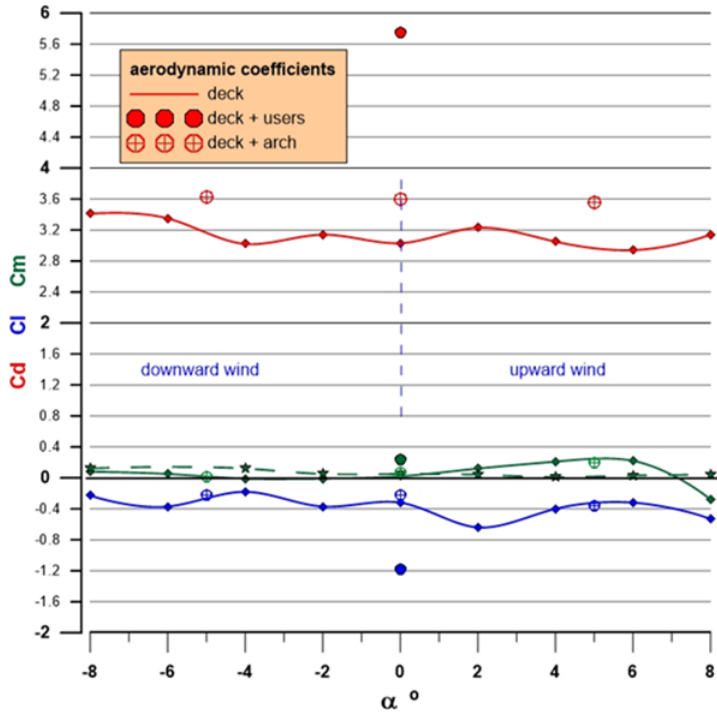
Figure 10. Evaluated aerodynamic coefficients.